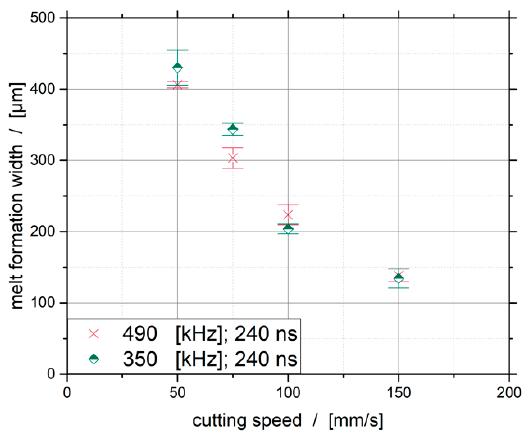
Figure 6. Influence of the cutting speed on the melt formation width.